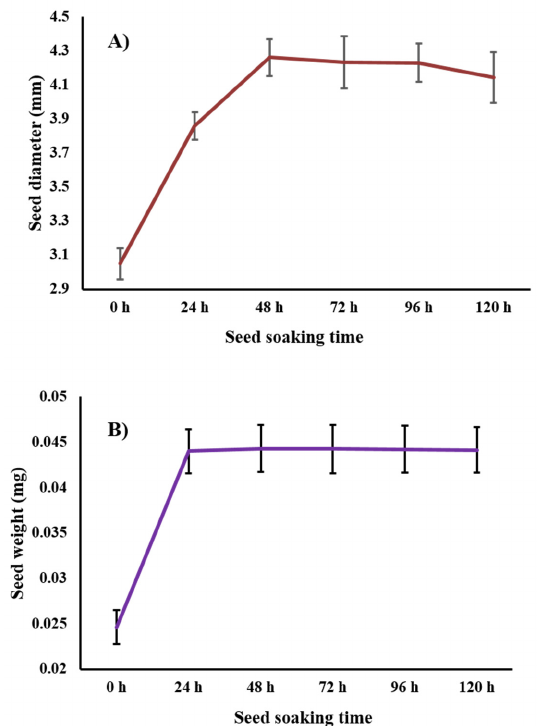
Figure 2. Determination of water uptake capacity measuring ( A ) diameter (mm) and ( B ) weight (mg) of seeds of G. superba soaked in water for different time intervals. Bar indicates standard deviation.